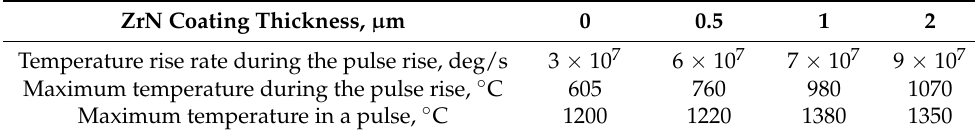
Table 4. Surface temperature characteristics for the bare and ZrN-coated silumin samples subjected to pulsed electron beam treatment.